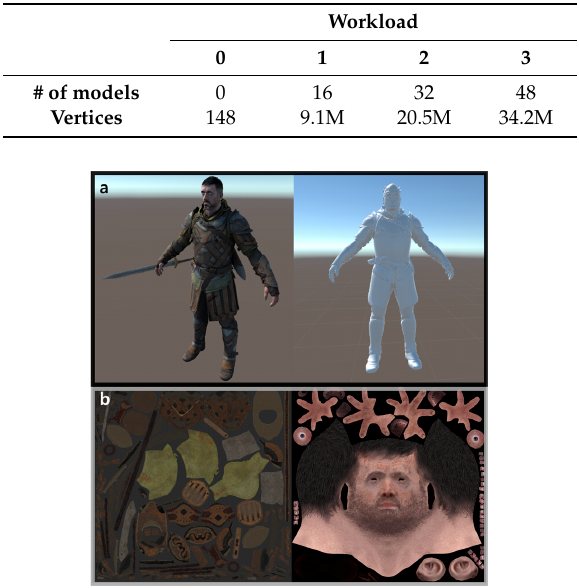
Table 4. The number of vertices for workload change.